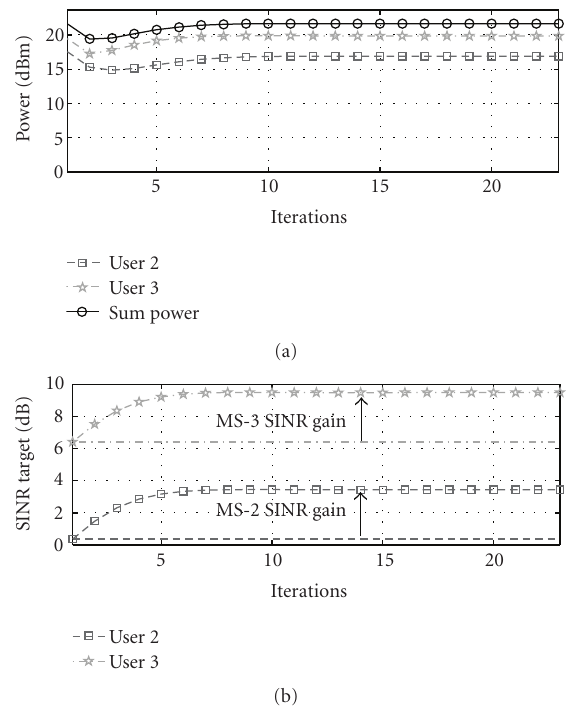
Figure 11: Precoding gain in SINR target selection. The figure shows that for the 2 × 4 MIMO case with a power budget 21.6 dBM, optimizing the precoder matrices allows to increase the original (without precoding) optimal SINR targets for the same power budget. This gain is more than 3 dB per user. Table 1: Input parameters of the 3-cell OFDMA system.